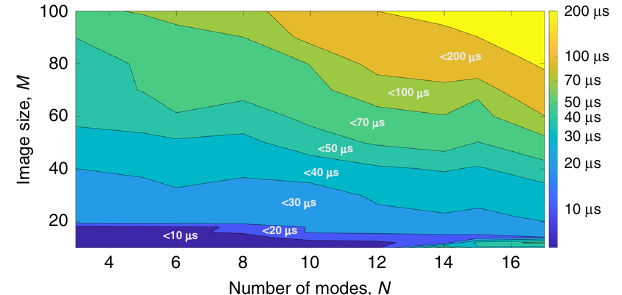
Fig. 3 Time performance. Mean decomposition time for different image sizes and number of modes. Decomposition time is color-coded. Source data are provided as a Source Data